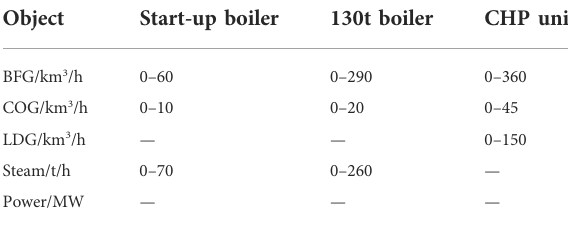
TABLE 4 Controllable unit information.